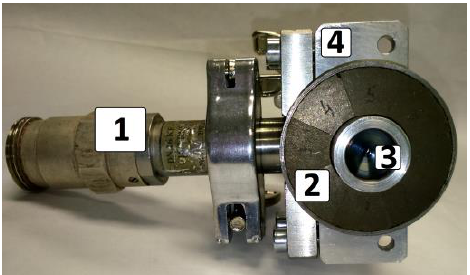
Fig. 2. The view of ECR ion source: 1 – coaxial input, 2 – magnet ring, 3 – plasma electrode, 4 –